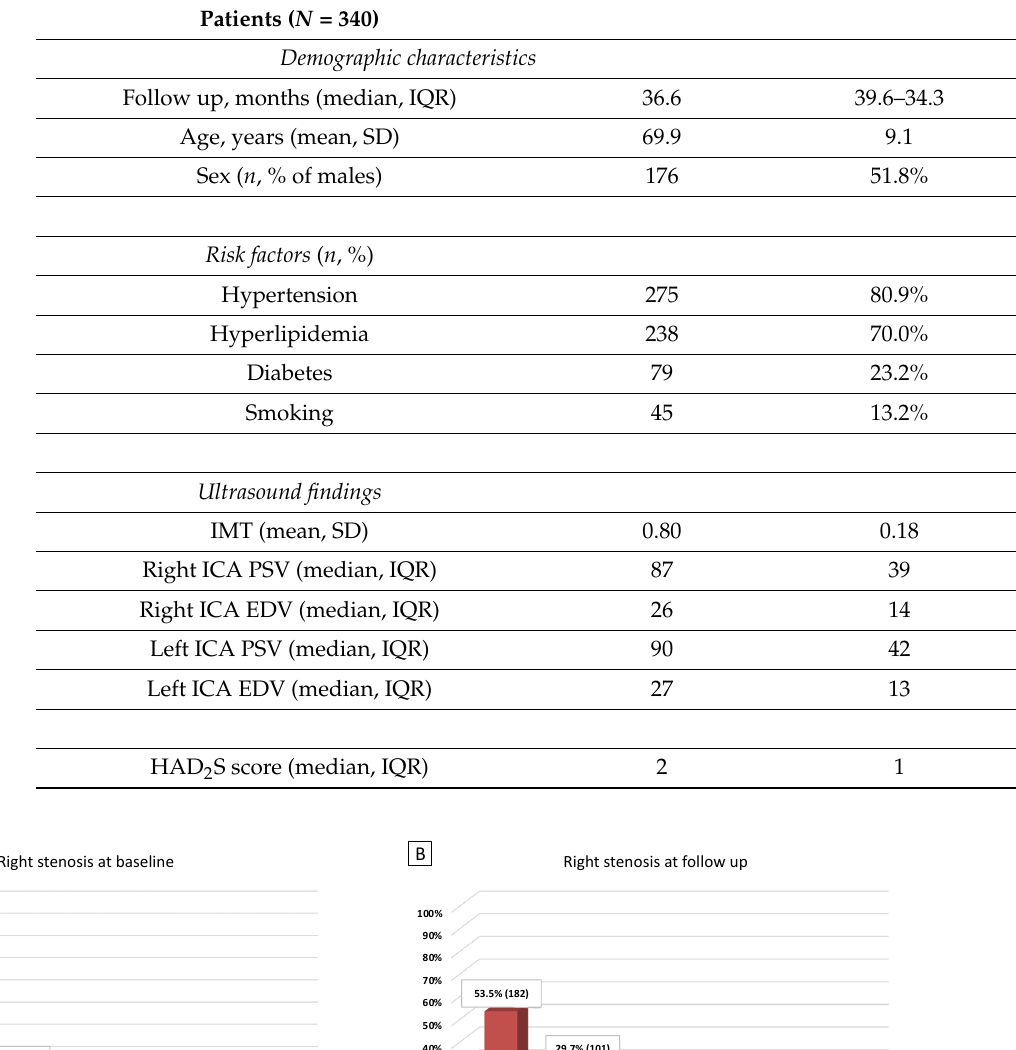
Table 1. Demographic characteristics, ultrasound findings, percentage of vascular risk factors and the median HAD 2 S score at baseline.